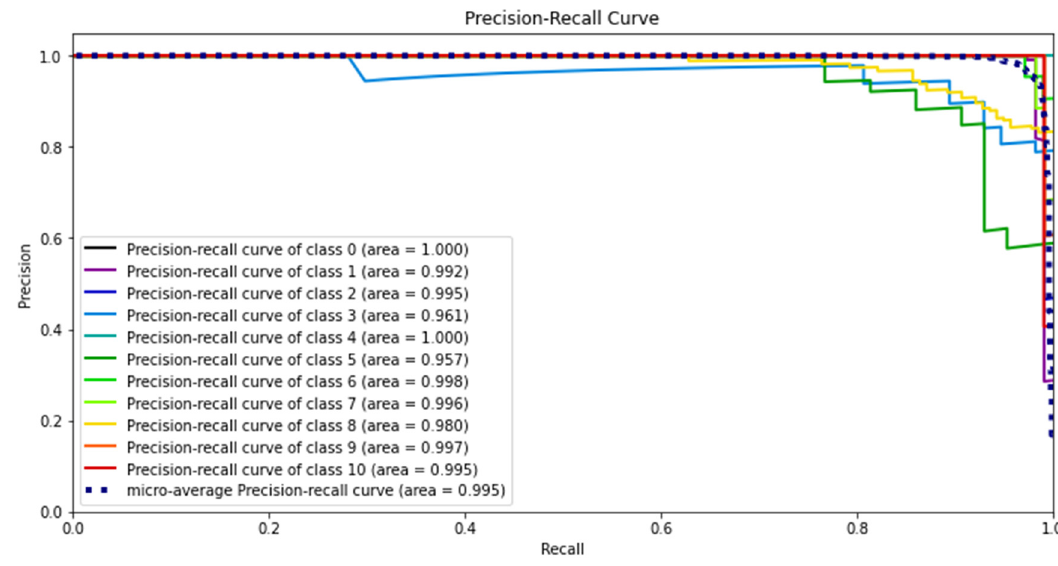
Figure 15. Precision–recall curve of the SVM with the RBF classifier using version 2 of the dataset. Table 10. Memory utilization of the machine learning classifiers on version